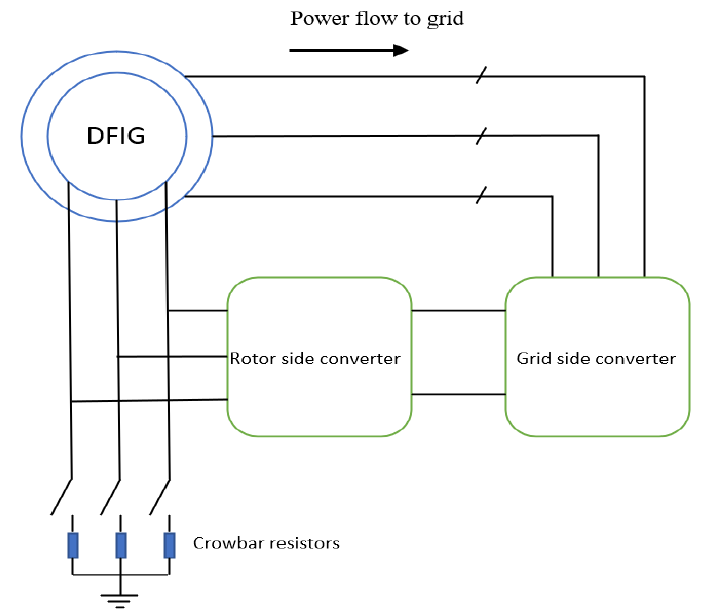
Figure 5. Stator natural flux for short-circuit rotor terminals.